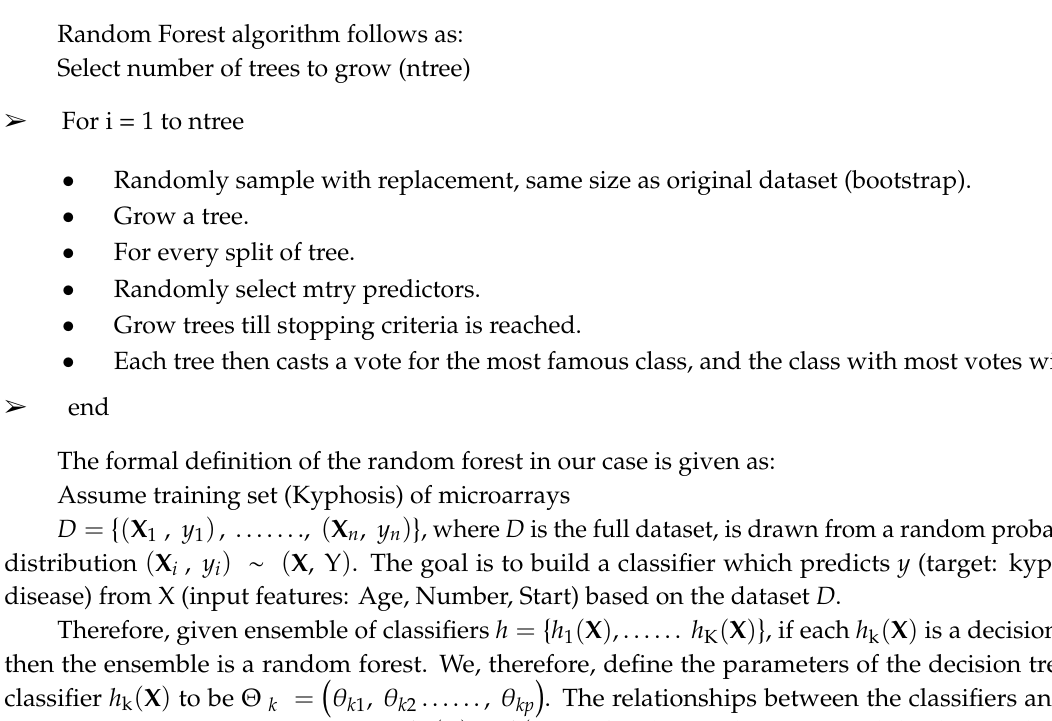
Figure 4. Structure of a Random Forest [21].